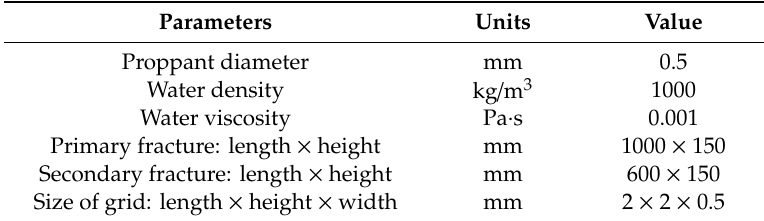
Table 1. Parameter values in the numerical simulation.